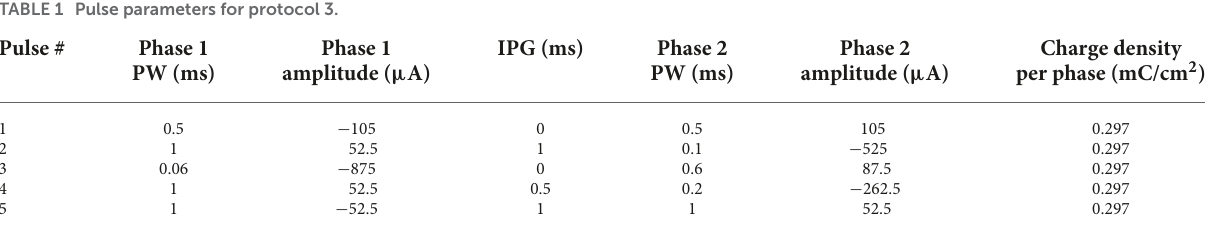
TABLE 1 Pulse parameters for protocol